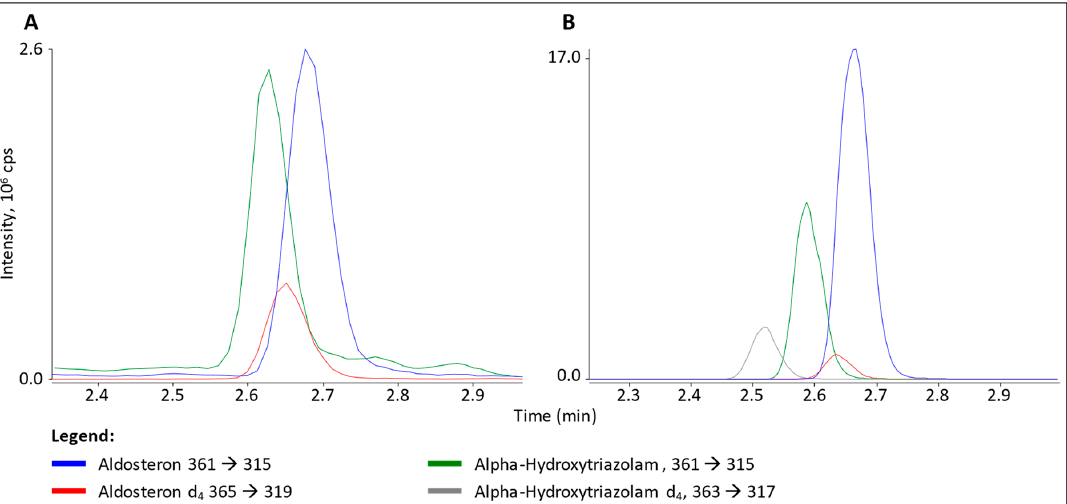
Figure 3. ( A ) α -OH-TZM as observed in ALDO quantifier ion trace (green) screening a QC sample of a benzodiazepine TDM kit (Recipe). ALDO quantifier (blue) and IS (red) ion trace of a high calibrator sample are overlayed for comparison. ( B ) Overlay of ion trace chromatograms from analyzing pure solutions of ALDO (blue), α -OH-TZM (green) and their respective d 4 labelled internal standards (red and grey).